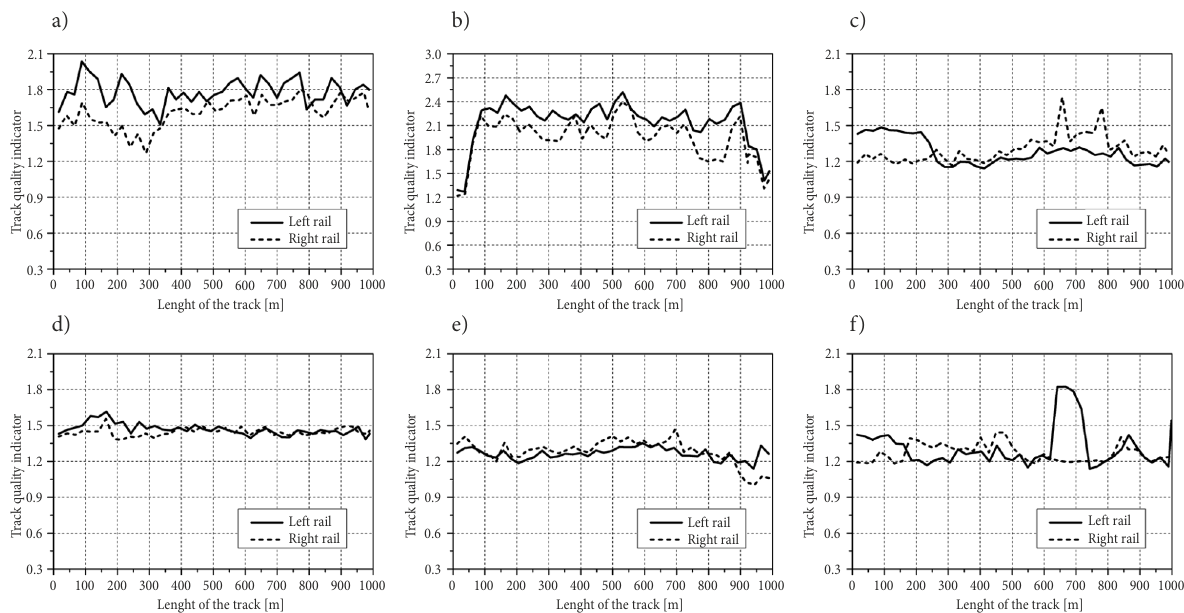
Fig. 8. TQI values obtained at the running velocity of v = 70 km/h (for each graph, data recording started at the points illustrated on the diagram in Fig. 6)